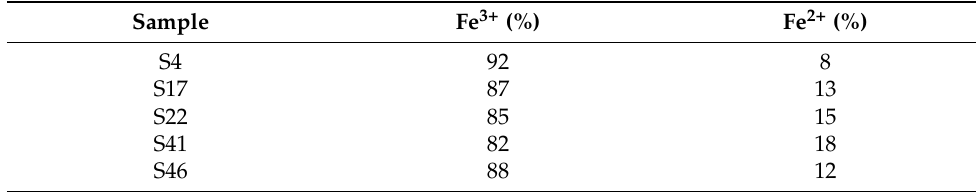
Table 3. Relative amounts of Fe 3+ and Fe 2+ cations as determined by LCF analysis of Fe K-edge XANES spectra of the Spirulina